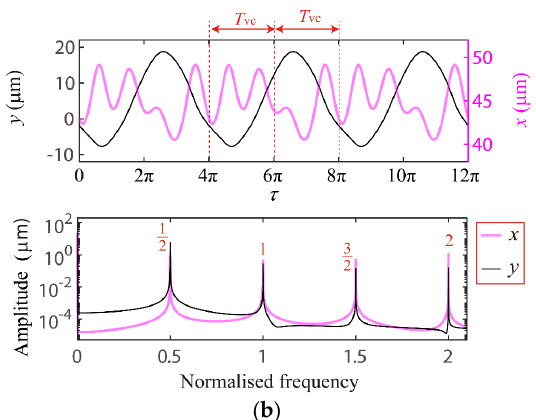
Figure 29. Response characteristics of the VC period-2 motion when Ω = 88 rad/s, ( a ) orbit (black line) and its Poincare mapping (red dots), ( b ) time series and their frequency spectra.